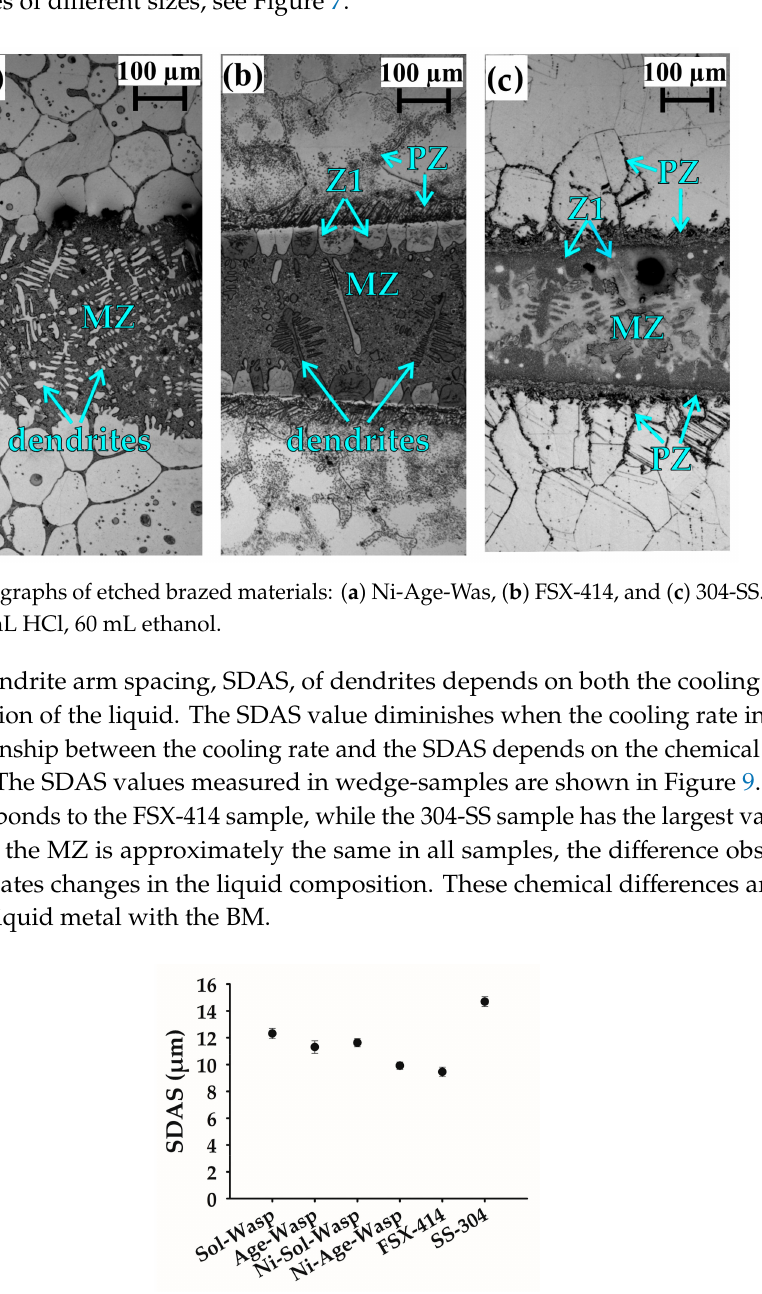
Figure 9. Values of the secondary dendrite arm spacing, SDAS, measured in the melting zone of the